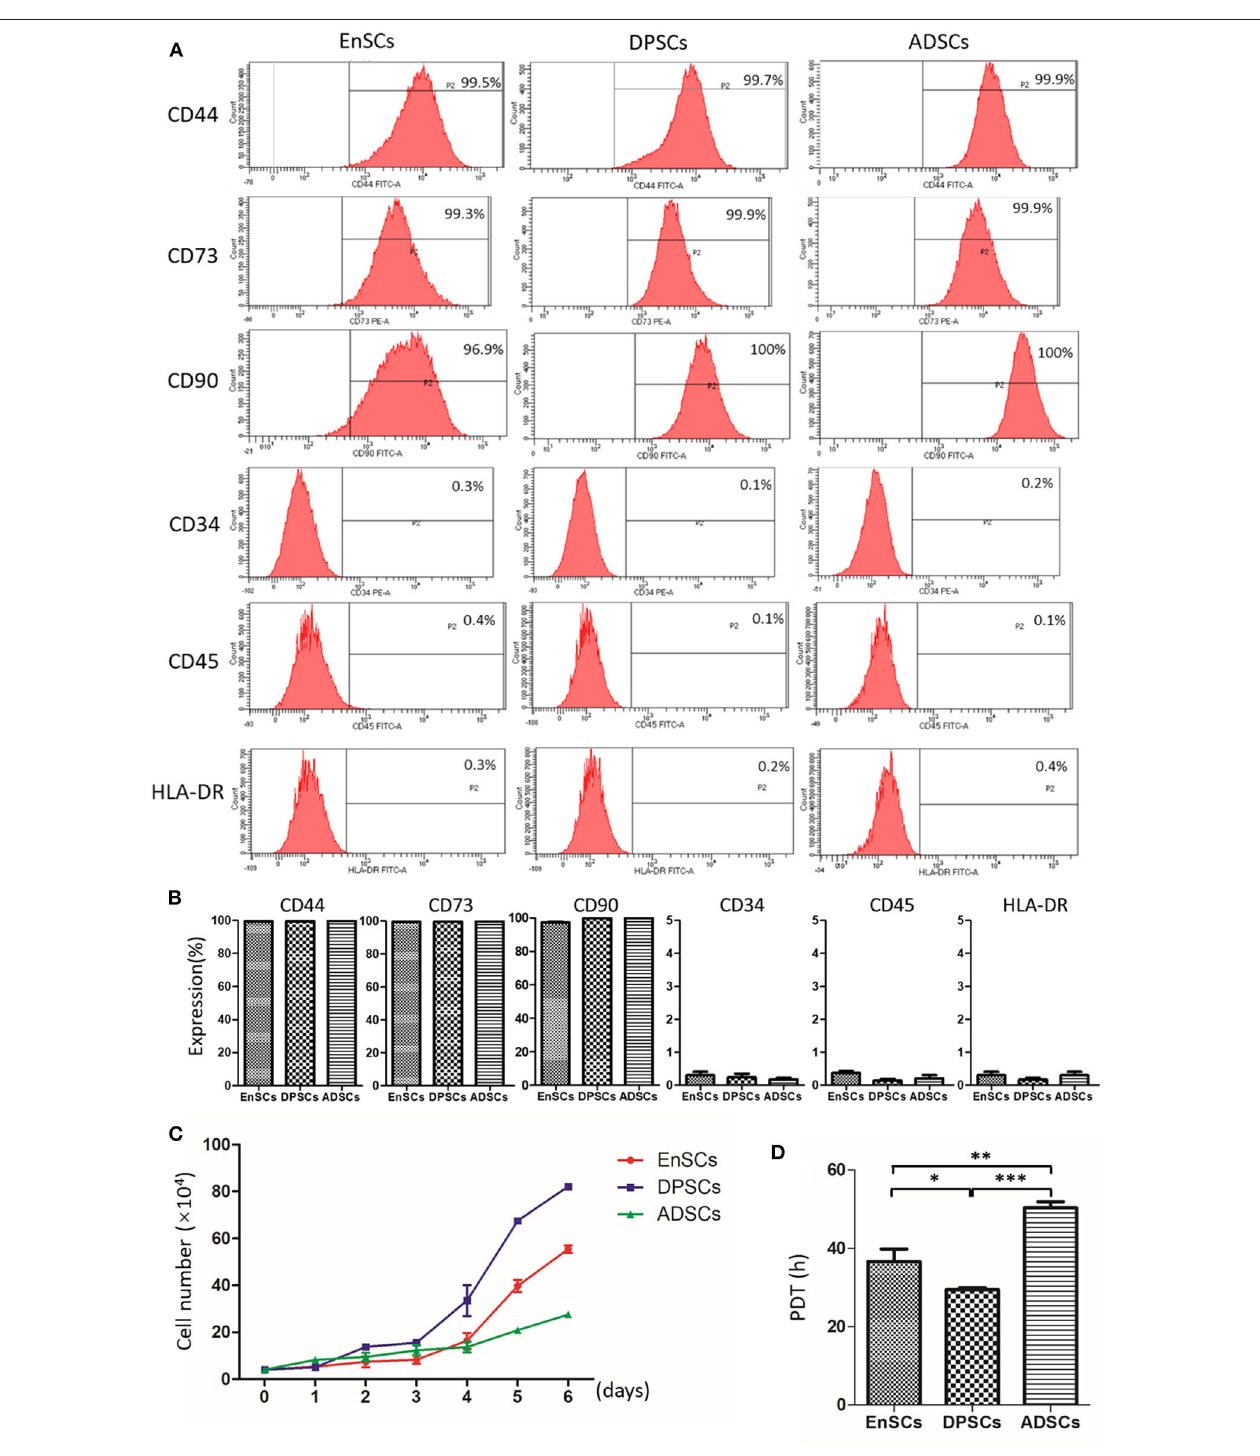
FIGURE 3 | Immunophenotype and proliferative potential of hEnSCs, hDPSCs and hADSCs. (A,B) Flow cytometric analysis of the expression of surface markers on MSCs. Shown (A) is one representative of 3 independent experiments. (C) Growth curves of MSCs ( n = 3 donors). (D) PDT of MSCs from different types were analyzed and compared (* p < 0.05, ** p < 0.01, *** p < 0.0001).